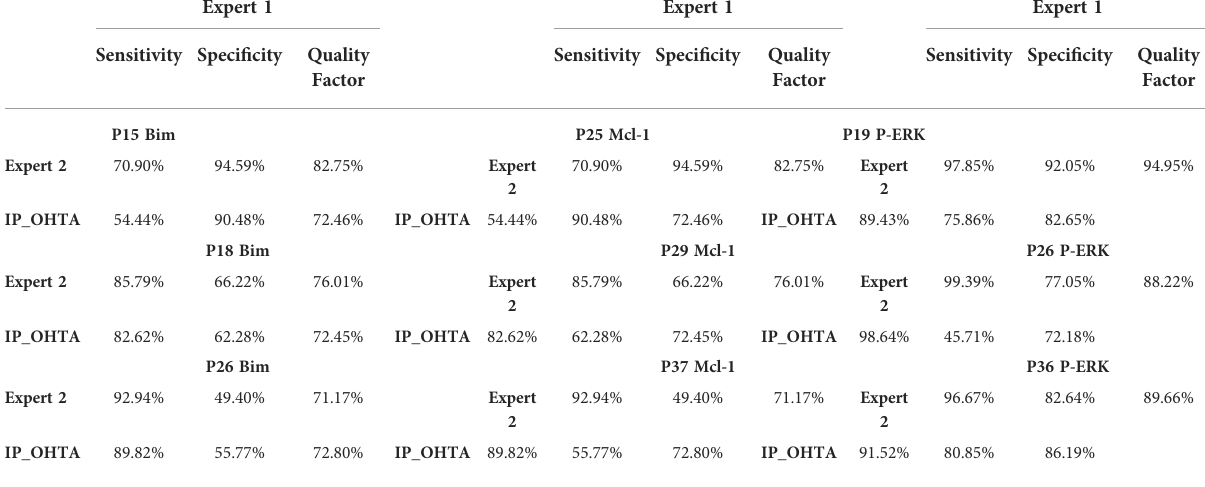
TABLE 2 Quality factors: factors between two experts and factor between reference expert and image processing (one table/marker).